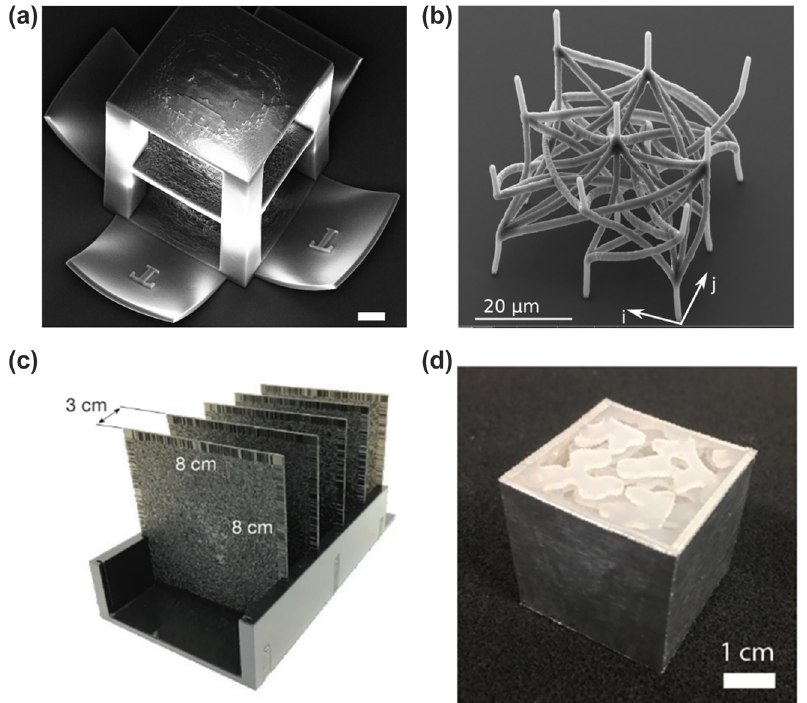
Figure7: Different modalitiesfor3D opticalcir- cuitry. (a) Multilayer computer-generated opti- cal volume element as an interconnect working in the optical domain printed by two-photon polymerization. The scale bar measures 20 μ m (Taken from [72], Copyright De Gruyter). (b) Waveguide interconnects with complex 3D rout- ing to perform image-processing filters (Taken from [80], Copyright Optica). (c) Diffractive deep neural network for various classification tasks experimentally demonstrated in the THz regime (Taken from [81], Copyright AAAS). (d) Volumet- ric element optimized by adjoint method for wavelengthandpolarizationsortingexperimen- tally demonstrated in the THz regime (Taken from [90], Copyright